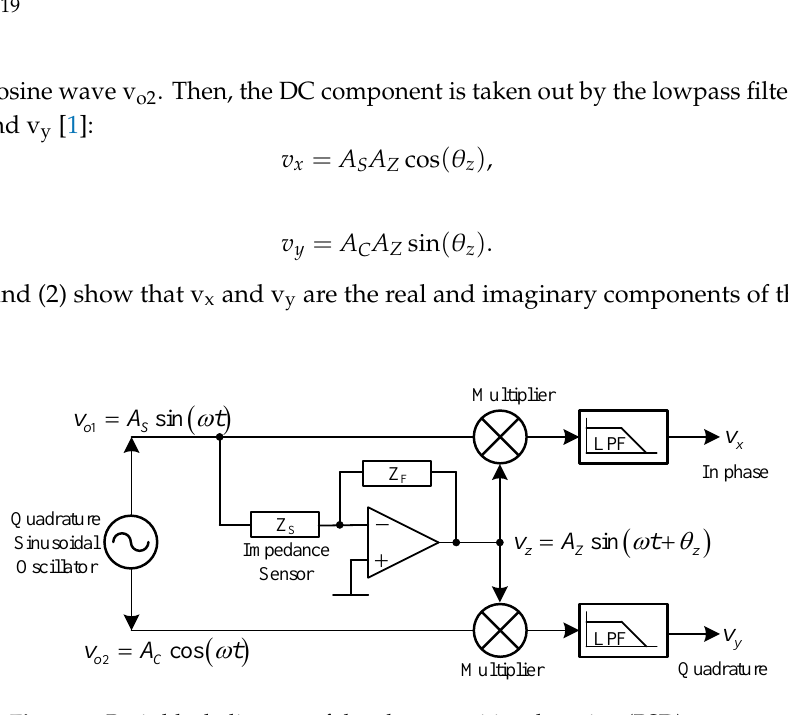
Figure 1. Basic block diagram of the phase sensitive detection (PSD) system.